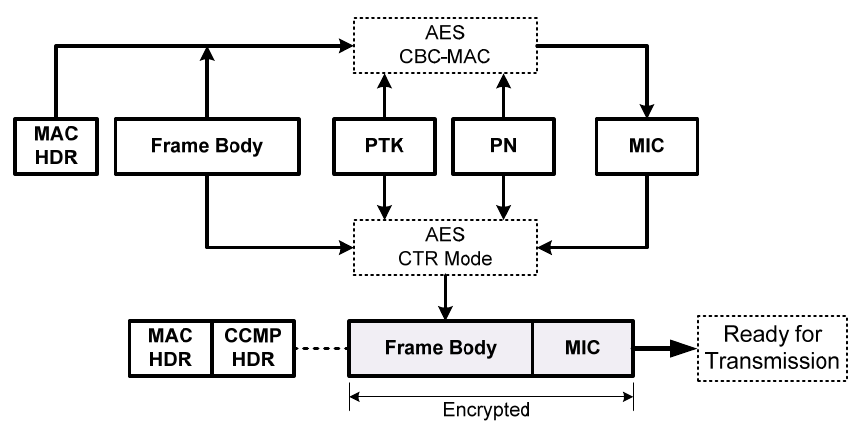
Figure 12. The working principle of